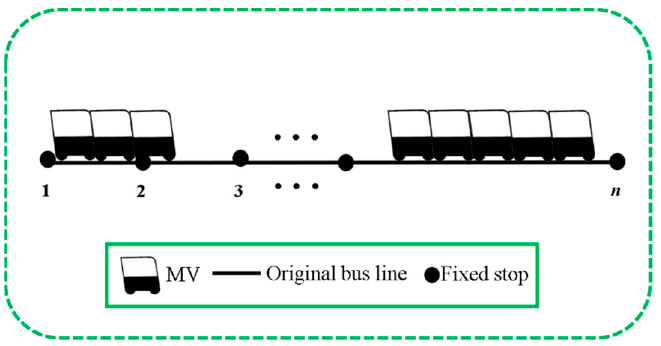
Figure 8. Regular operating scenario with large